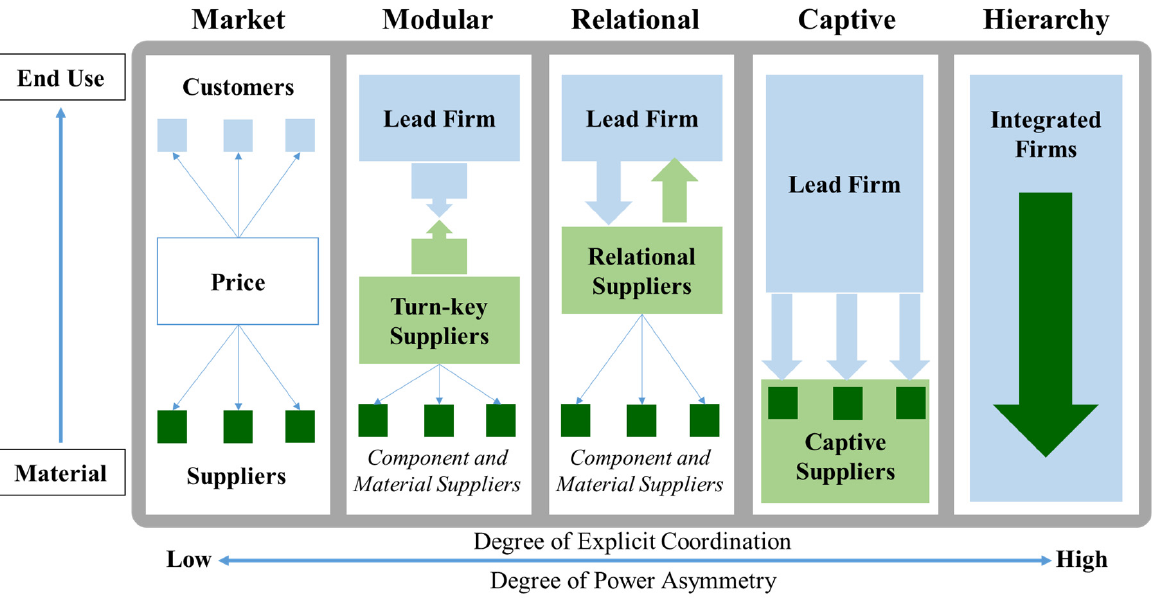
Figure 2. Five types of global value chain governance. Adapted from Gereffi et al. [18].